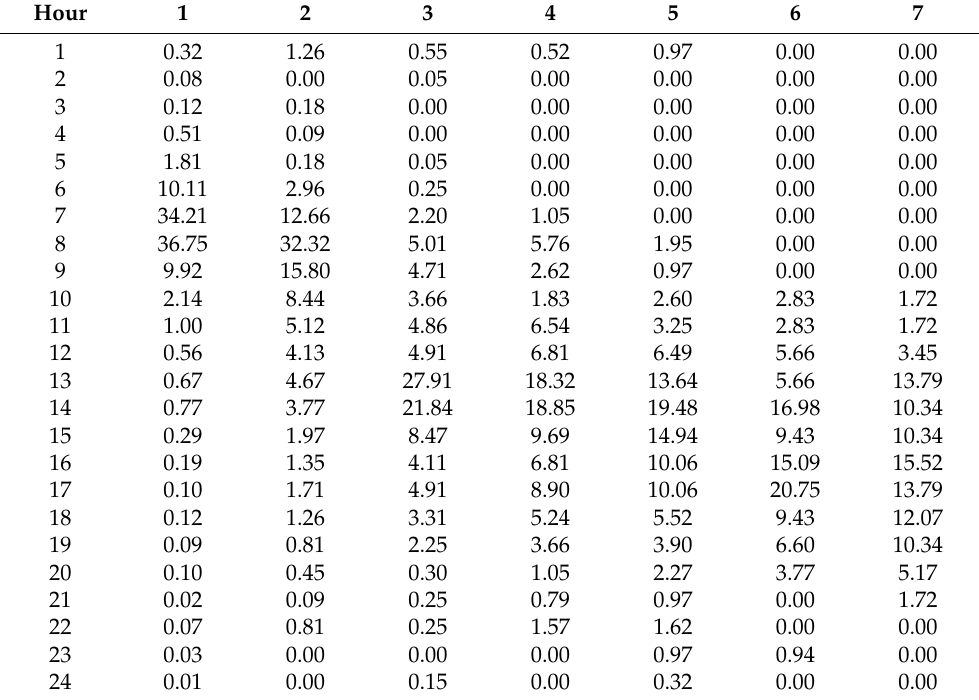
Table A1. Probability distributions of departure hours to work (%) by activity position in an activity chain.